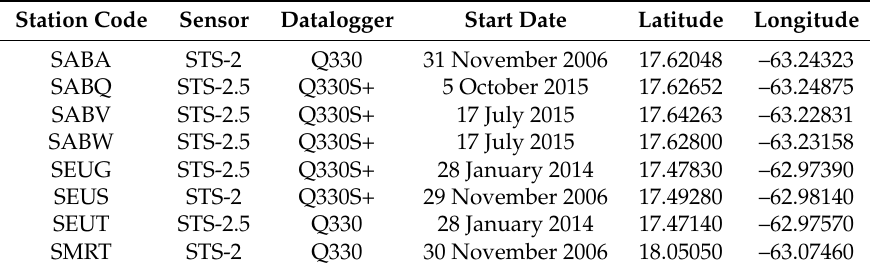
Table 2. Instrumentation and recording start dates of the individual seismometers in network